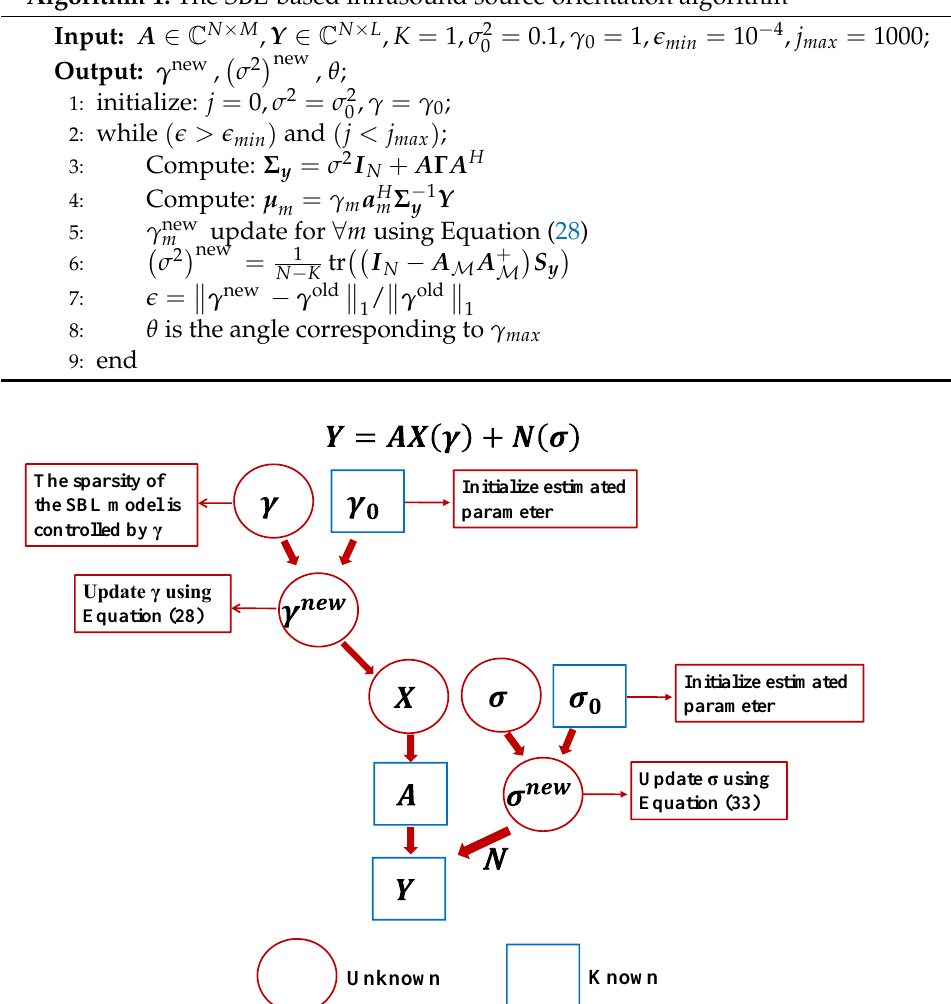
Figure 3. The structure diagram of Bayesian hierarchical model (blue rectangules denote the known parameters; red circles denote the unknown parameters). The initialized infrasound source power parameters γ 0 are used to update the parameters γ in the Equation (28), and the initialized infrasound source noise variance parameters σ 0 are used to update the parameters σ in the Equation